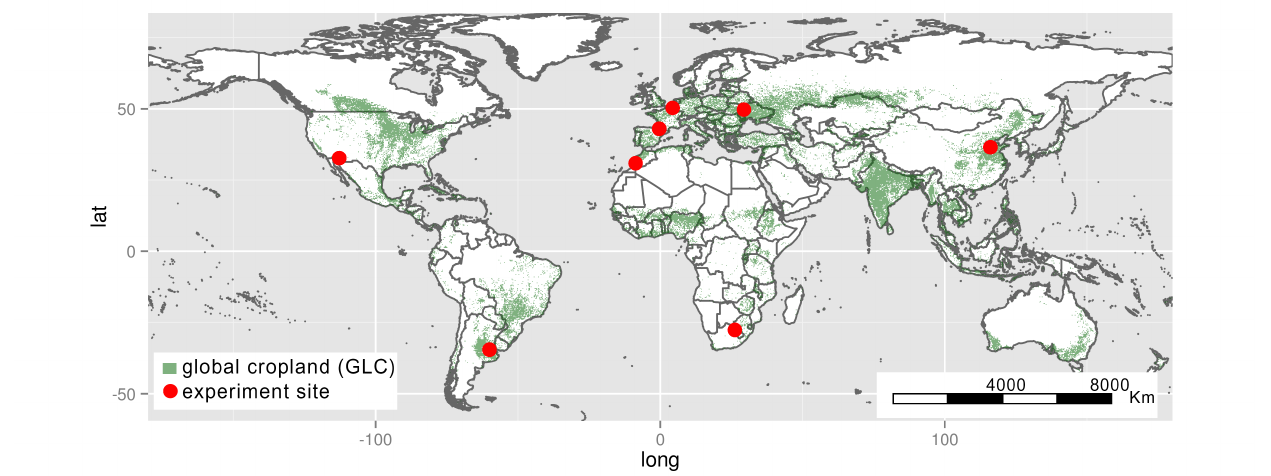
Figure 1. Eight sites selected throughout the world (red dots) to encompass some of the cropland diversity (global cropland in green from GLCShare